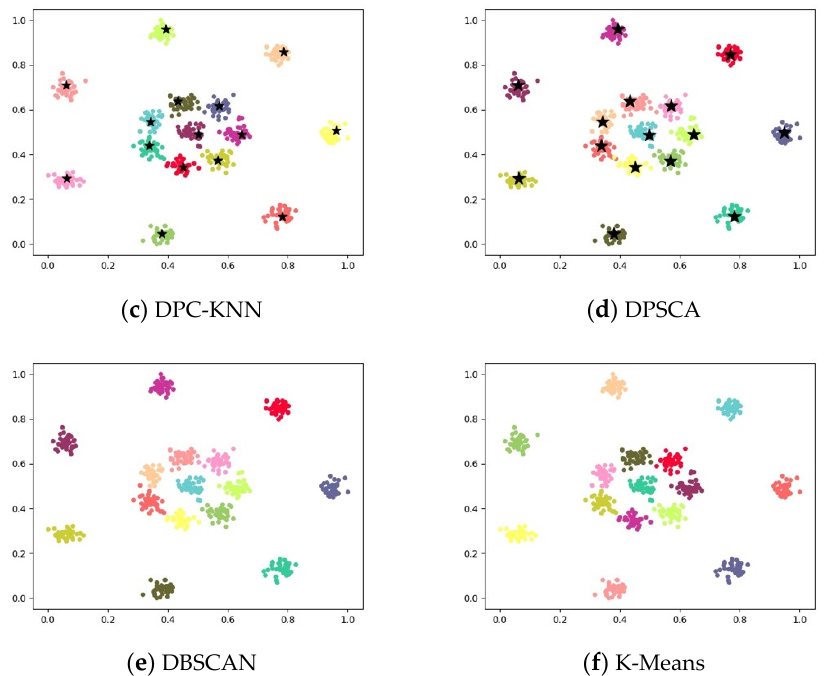
Figure 10. Clustering results on the R15 dataset.